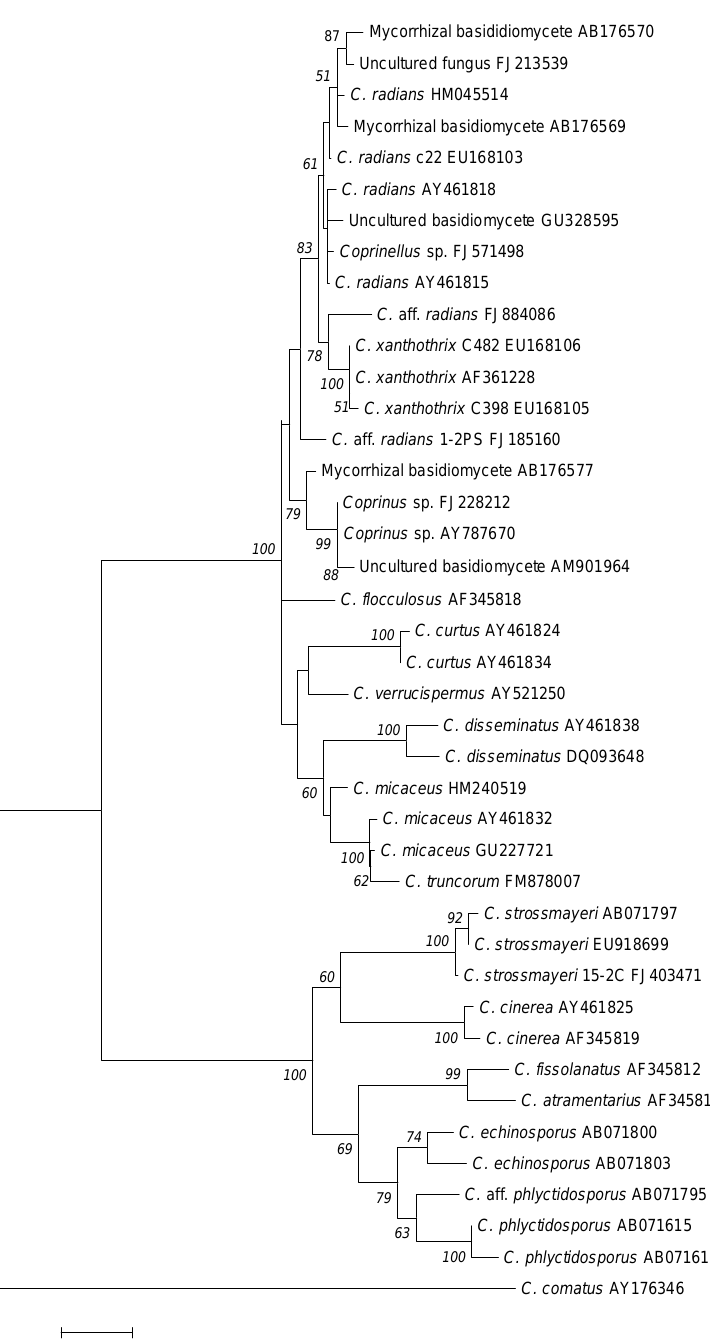
Figure 3. Phylogenetic tree of the ITS1-5.8S-ITS2 DNA sequences of coprinoid